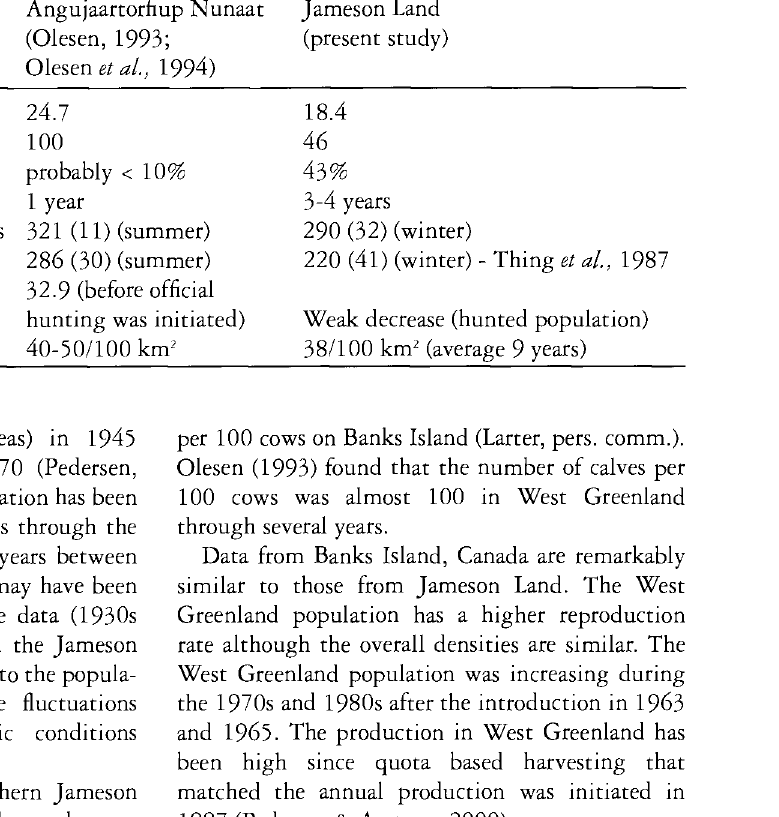
Table 4. Selected population parameters in Angujaartorfiup Nunaat (West Greenland) and Jameson Land. Population parameter Angujaartorfiup